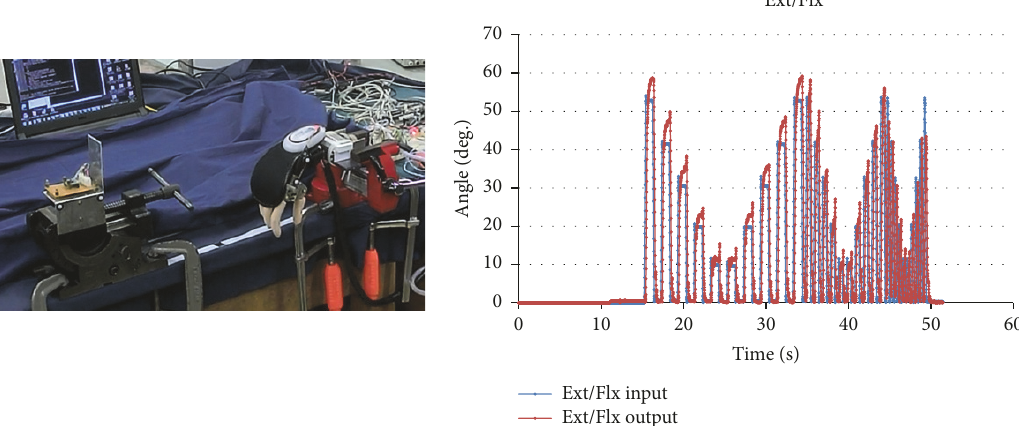
Figure 11: Results and experiment environment of flexion/extension joint.